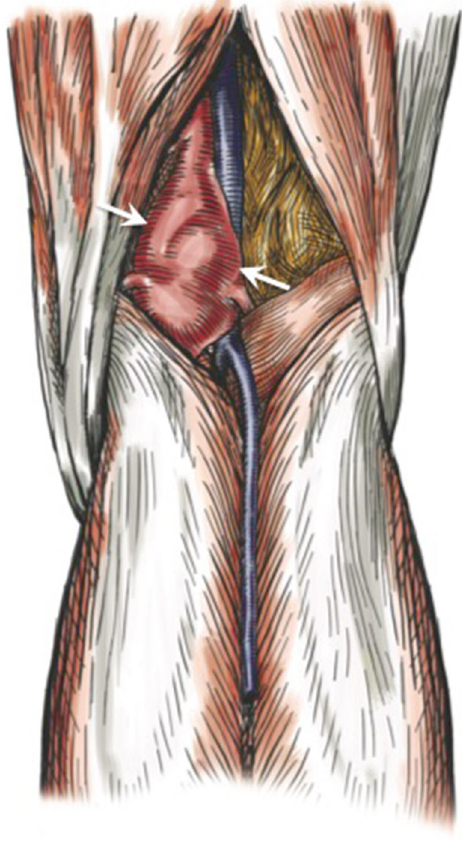
Fig. 8 Drawing illustrating a fusiform aneurysm of the popliteal artery